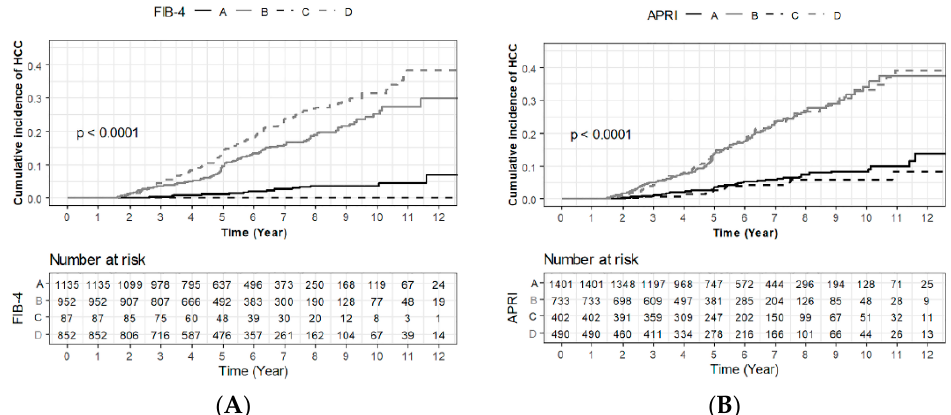
Figure 1. Cumulative probability of HCC development according to non-invasive fibrosis marker response groups at 12 months (groups A, B, C, and D) for FIB-4 ( A ) and APRI ( B ) among treatment- naïve CHB patients after initiating AVT. HCC, hepatocellular carcinoma; CHB, chronic hepatitis B; AVT, antiviral therapy.